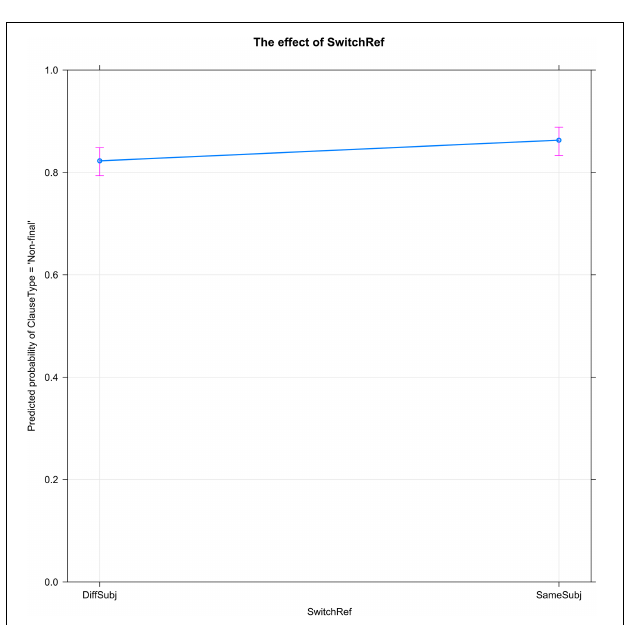
FIGURE 3 | Switch-Reference (SwitchRef) decreases the probability of clause linking (ClauseType = ‘Non-final’): the percentage of clause linking is lower when the subject referent is changed (DiffSubj) than when the same referent is maintained (SameSubj).